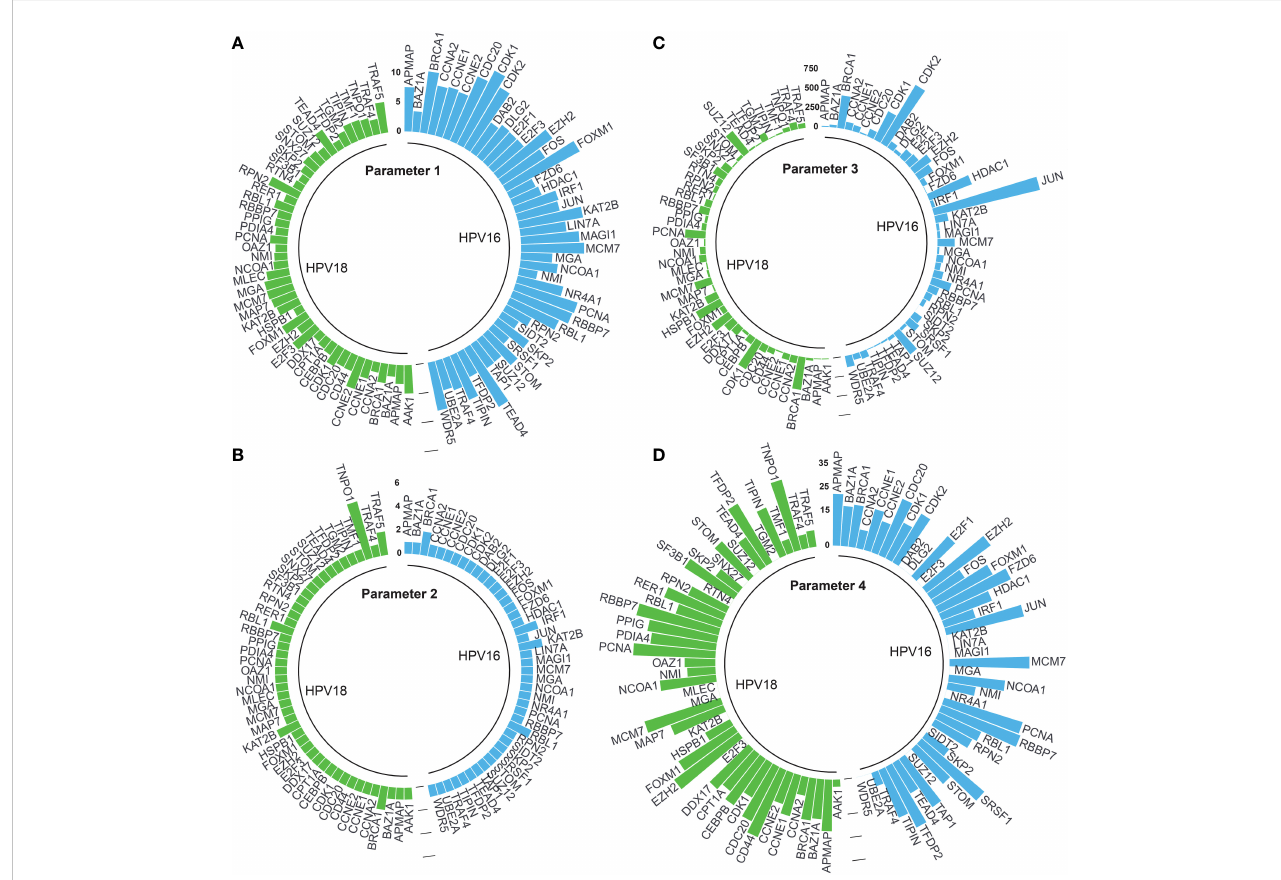
FIGURE 4 The circular bar graphs represent the results of the parameters determined in the study. (A) Parameter 1. The bar graph shows the values of differentially expressed host proteins (DE-HPs) at the adjusted p-value level (-log 10 ). (B) Parameter 2. The bar graph shows the number of interactions between DE- HPs and viral proteins. (C) Parameter 3. The bar graph shows the number of interactions between DE -HPs and human proteins. (D) Parameter 4. The bar graph shows the calculated HPA scores for the DE-HPs. The negative HPA scores were represented as “ 0 ”